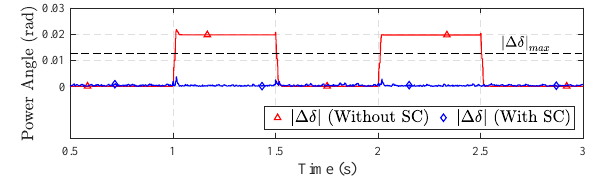
Figure 14. Power angle variation magnitude with and without the smart